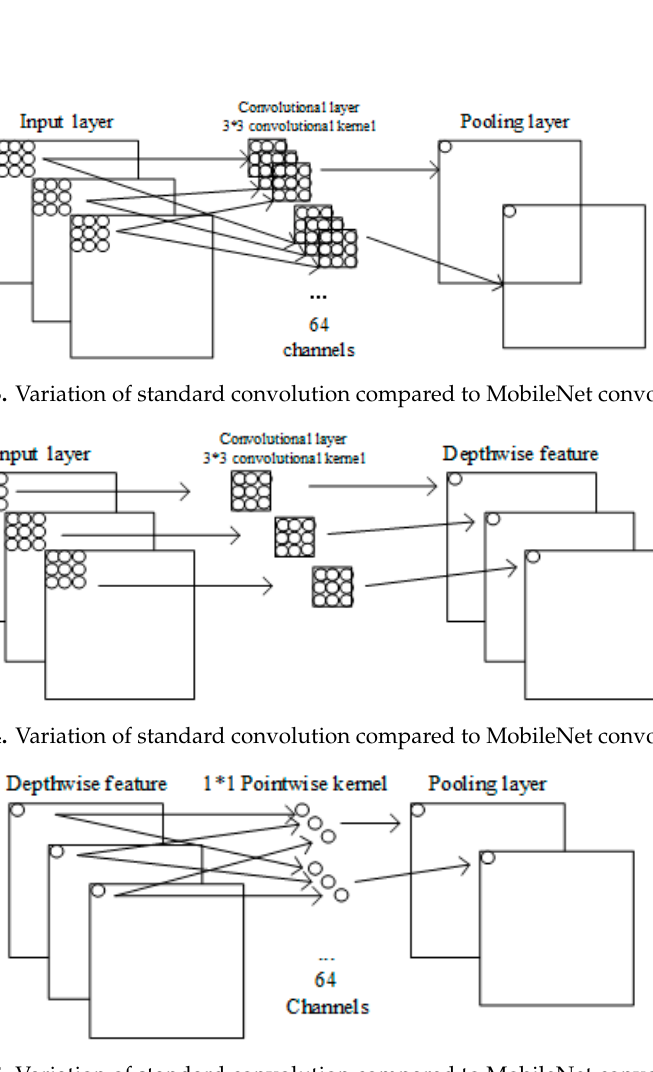
Figure 5. Variation of standard convolution compared to MobileNet convolution.